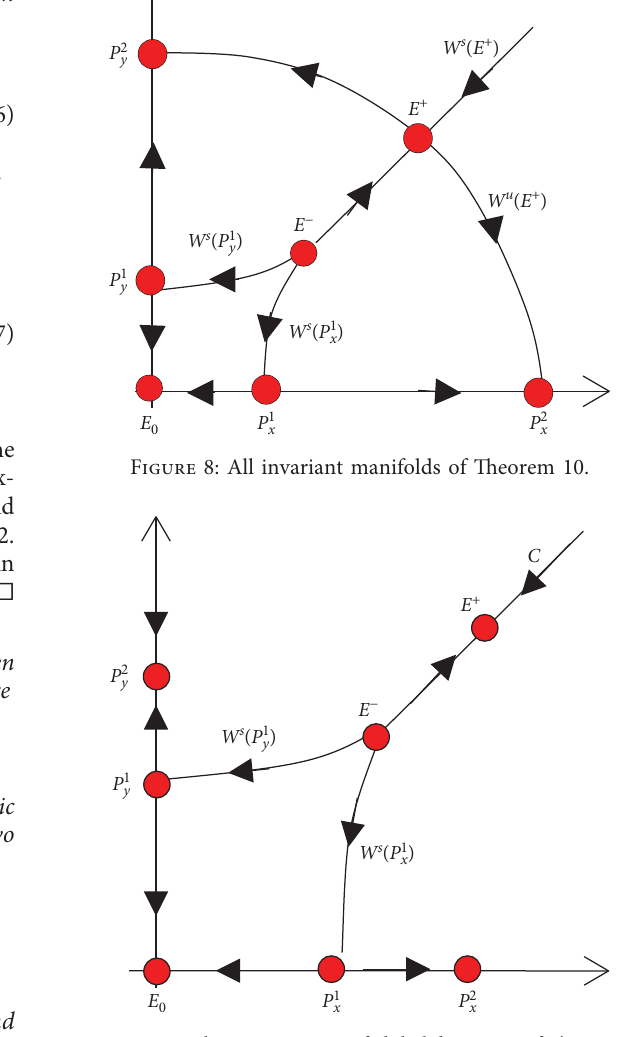
Figure 9: Visual representation of global dynamics of Theorem